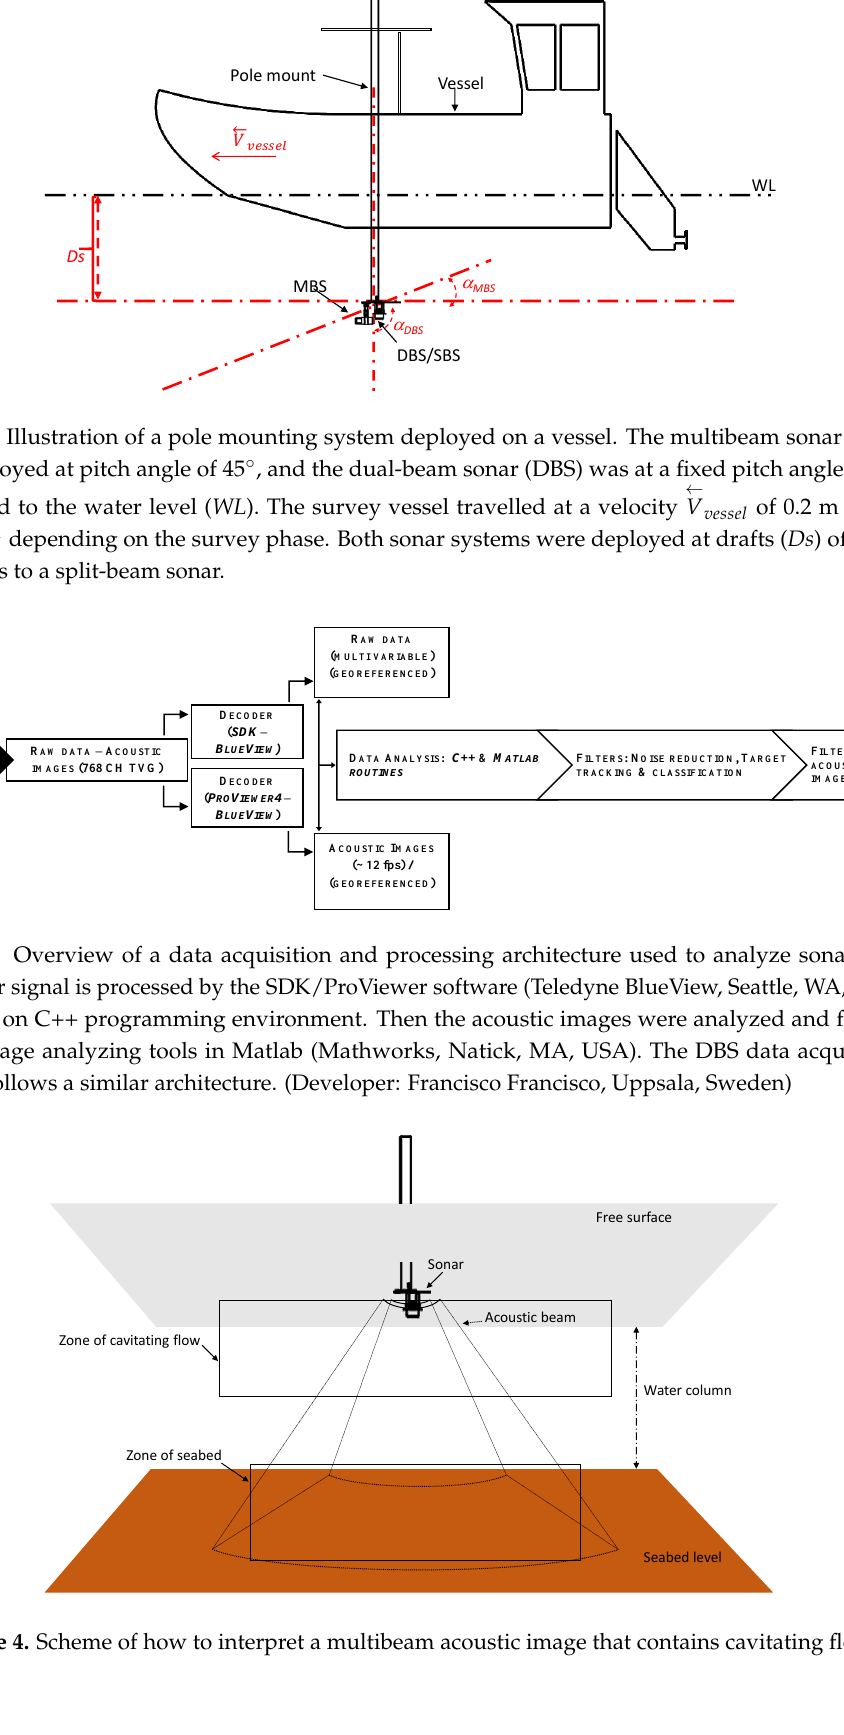
Figure 4. Scheme of how to interpret a multibeam acoustic image that contains cavitating flow.